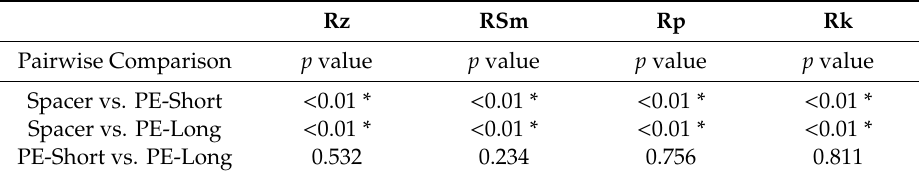
Table 5. Comparison of roughness parameters between the spacer group and two conventional hip arthroplasty revision groups (PE-Group Short = short implant time in situ, PE-Group Long = long implant time in situ). Table 6. Pairwise Comparison between all 3 Groups (Spacer, PE-Short, PE-Long).